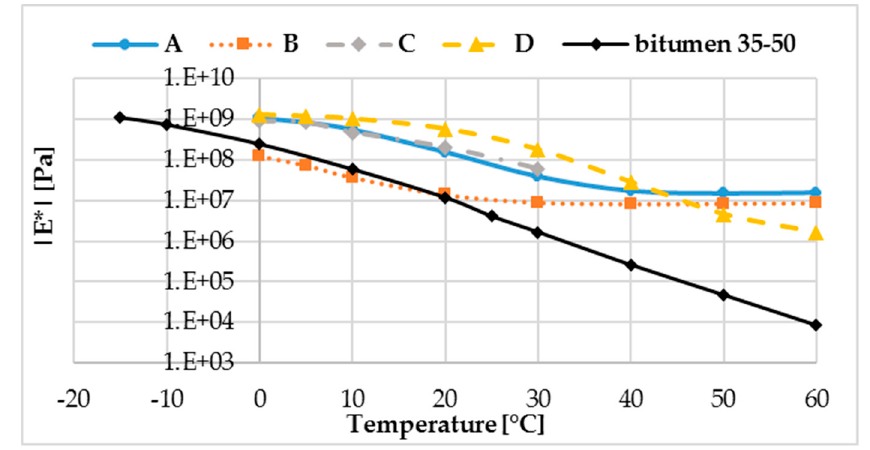
Figure 3. Complex modulus vs temperature for different polyurethanes cured at 20 °C.